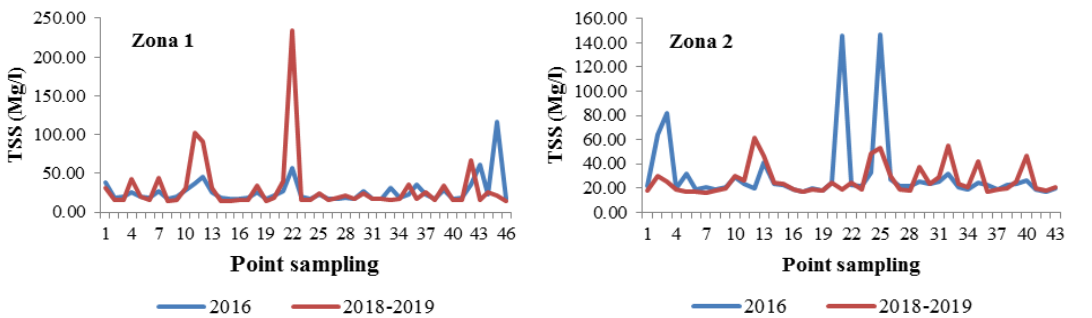
Figure 5. TSS (Mg / l) at each sampling point in Bontosua island as zona 1 and Ballang Caddi as zona 2 Spermonde waters in the west season December-February 2016 and 2018-2019 .